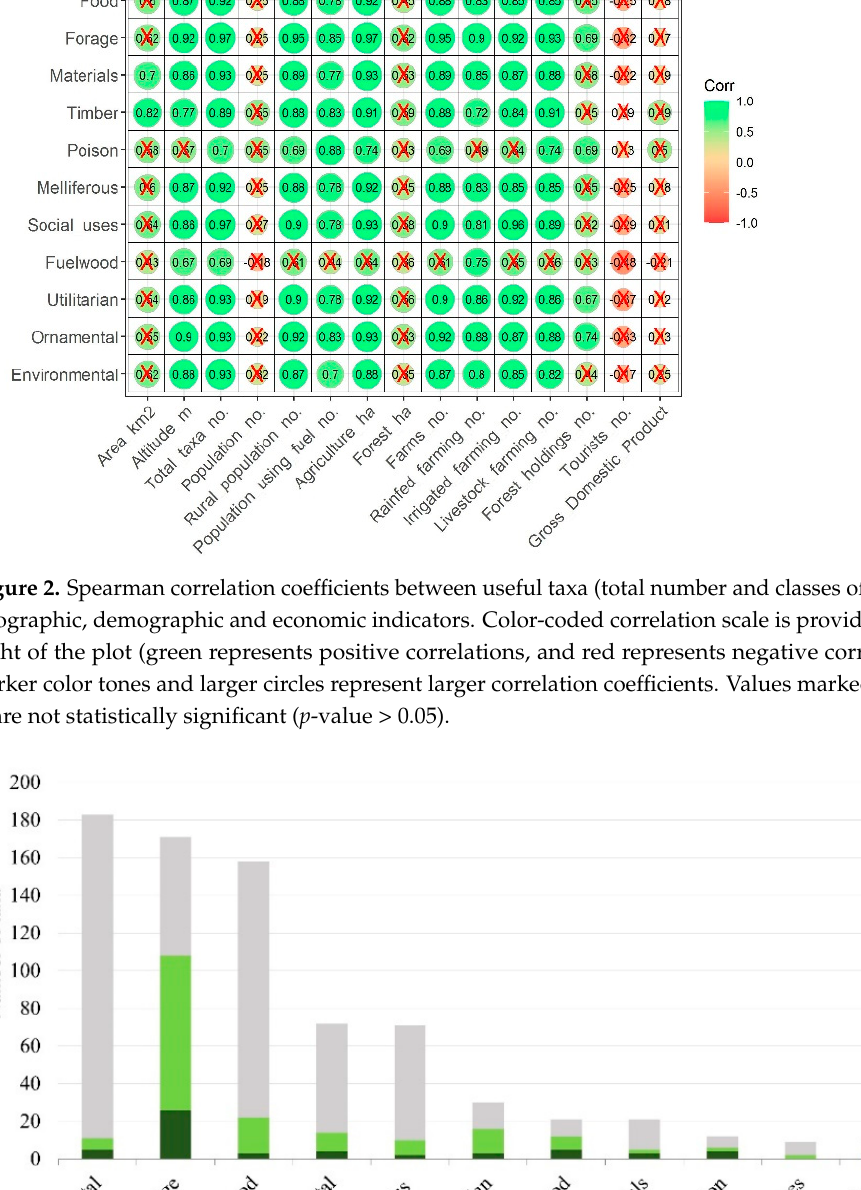
Figure 2. Spearman correlation coefficients between useful taxa (total number and classes of use) and geographic, demographic and economic indicators. Color-coded correlation scale is provided on the right of the plot (green represents positive correlations, and red represents negative correla- tions); darker color tones and larger circles represent larger correlation coefficients. Values marked with an X are not statistically significant ( p -value > 0.05).